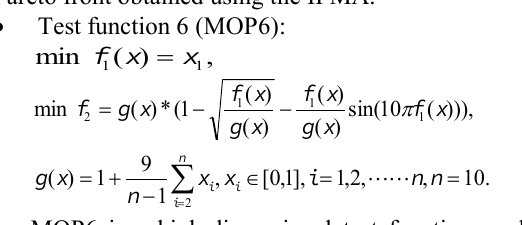
Fig.1 Pareto front of MOP1